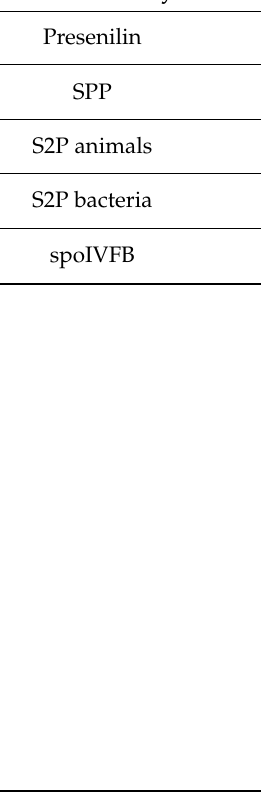
Table 1. Conserved TM motifs in protease families. The table below shows the conserved motifs in TM domains of five families of proteases as well as a C-terminal motif similar to the CPALLY motif in the N-terminus of the LIV-1 family of zinc transporters. The arrows indicate the direction of the motif within the TM domain showing consistency in each species. YD LGLGD